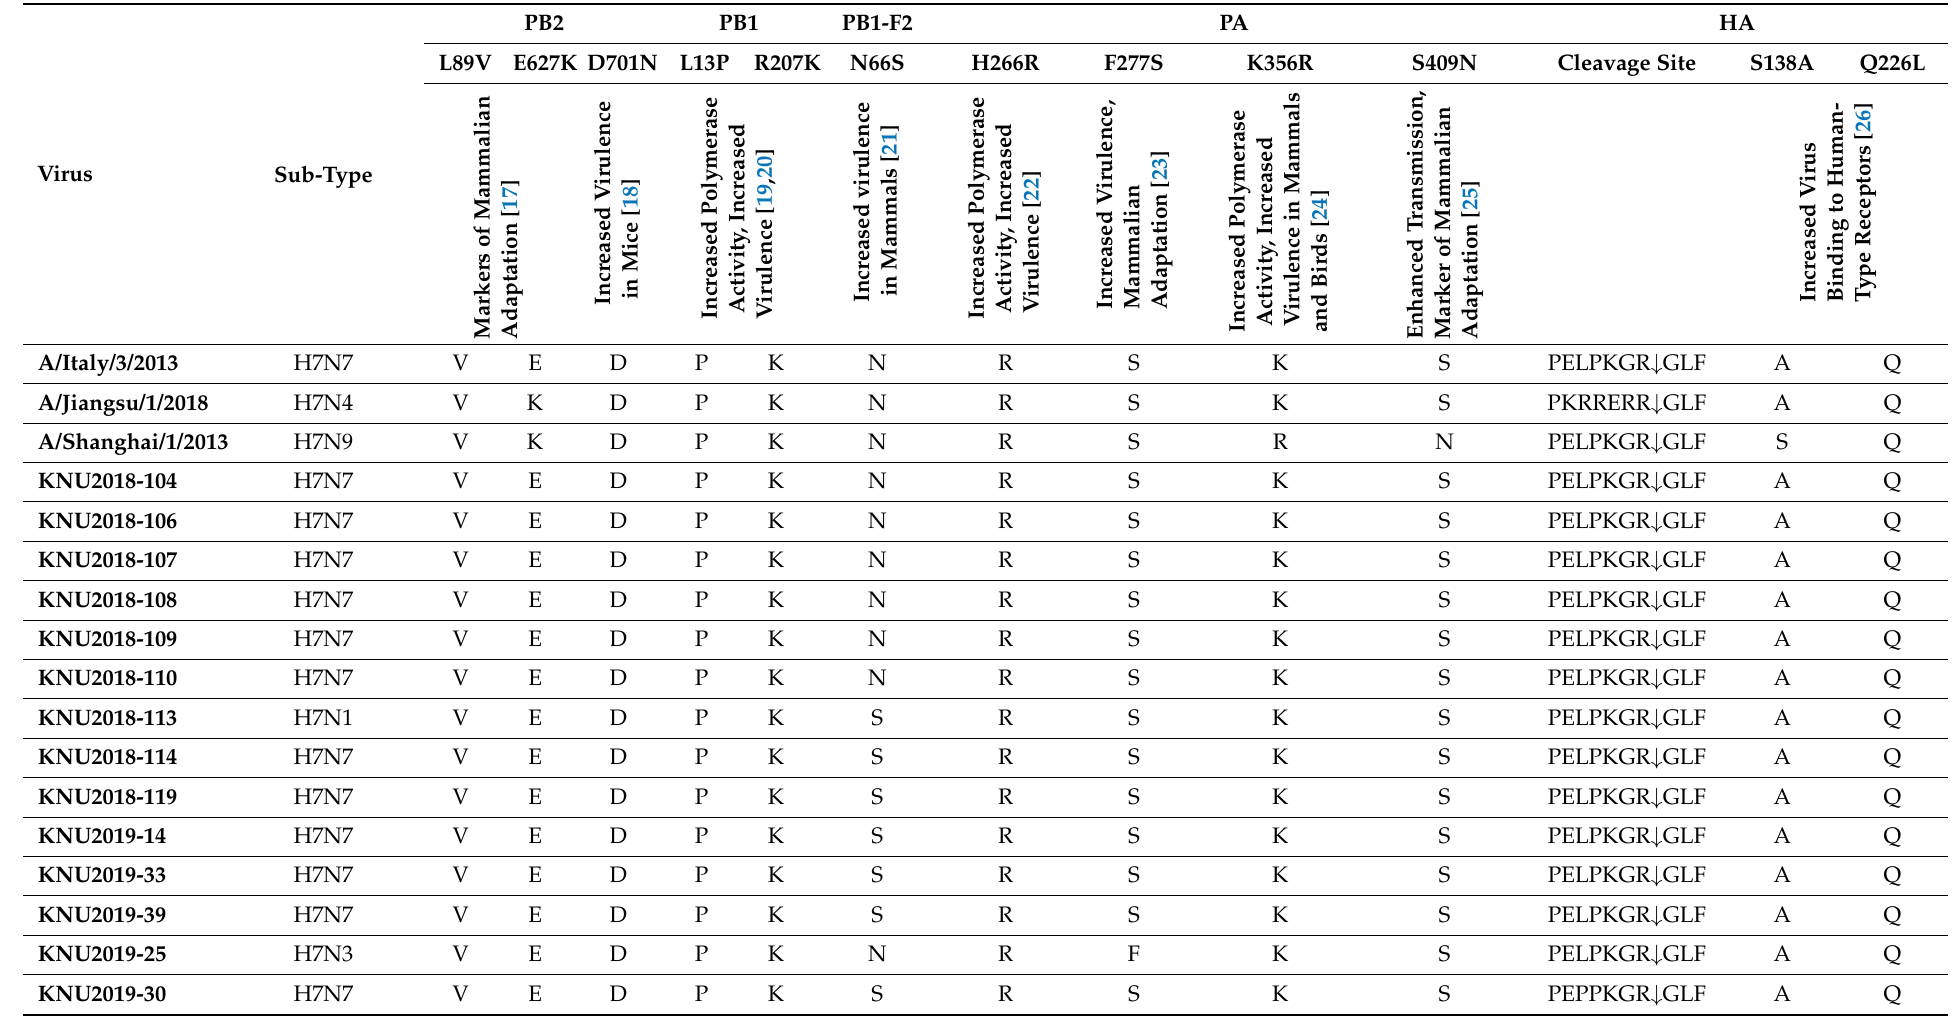
Table 1. Summary of data obtained from the mutational analysis of PB2, PB1, PA, and HA segments from the H7 isolates sampled during 2018–2019 in the Republic of Korea.